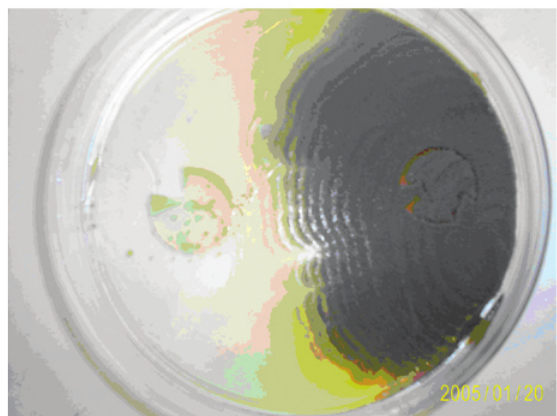
Figure 3: Fungal growth over a Hydron (expiry date 2003) blister packed contact lens after twenty six days of incubation. (Please ignore the date due to incorrect camera settings.)